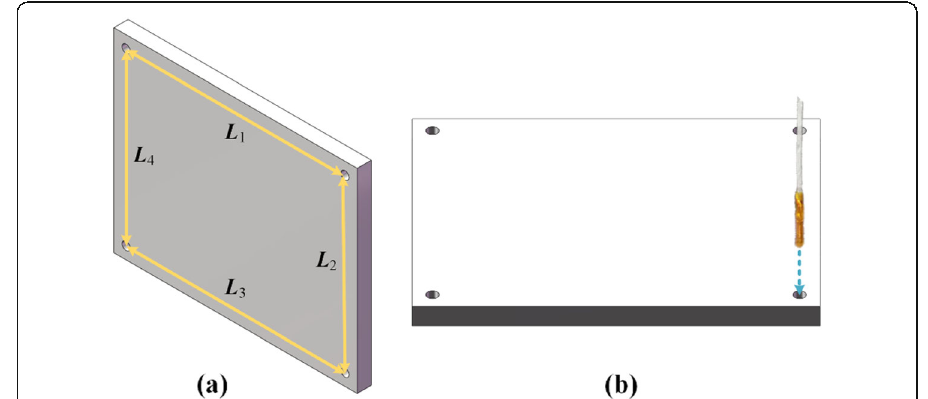
Fig. 9 A square board phantom is constructed to verify the accuracy of surgical